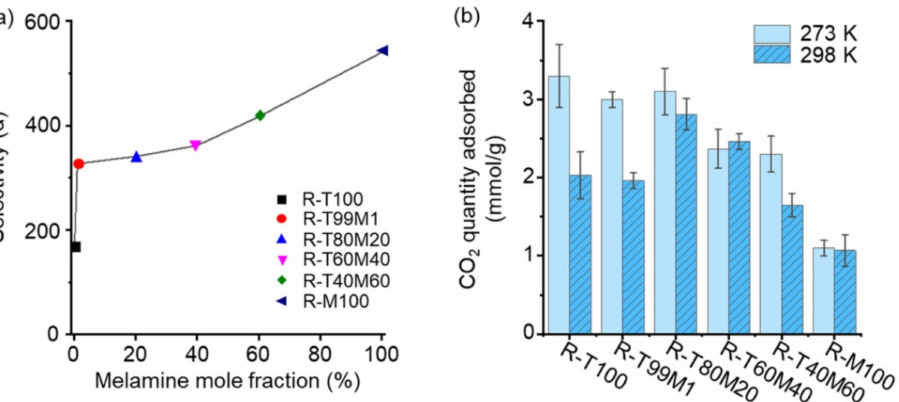
Figure 4. CO 2 adsorptivity of co-RUNs. ( a ) The IAST adsorption selectivity at 1 bar. ( b ) CO 2 adsorption quantity at 1 bar for co-RUNs collected at 273 K and 298